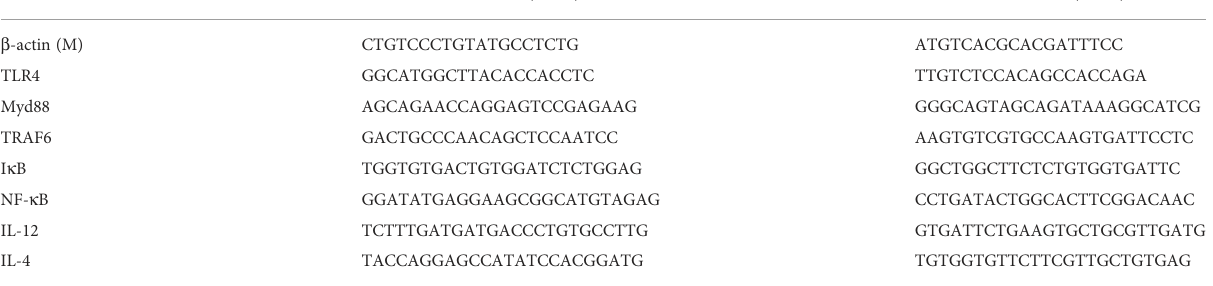
TABLE 1 RT-PCR ampli fi ed